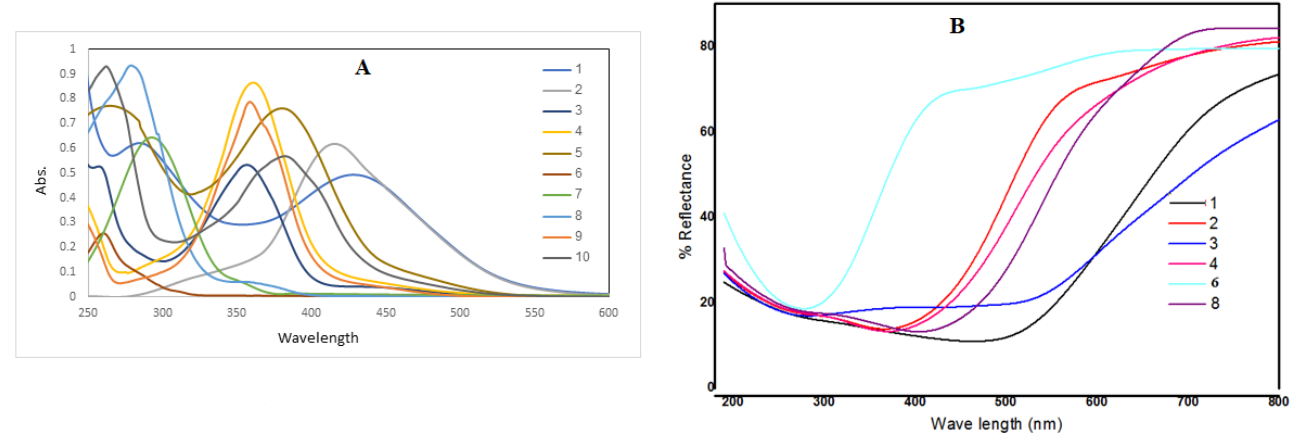
Figure 4. ( A ) Absorption spectra of azo dyes 1 – 10 in chloroform, ( B ) Reflectance curves of the dyed polyester fabrics.